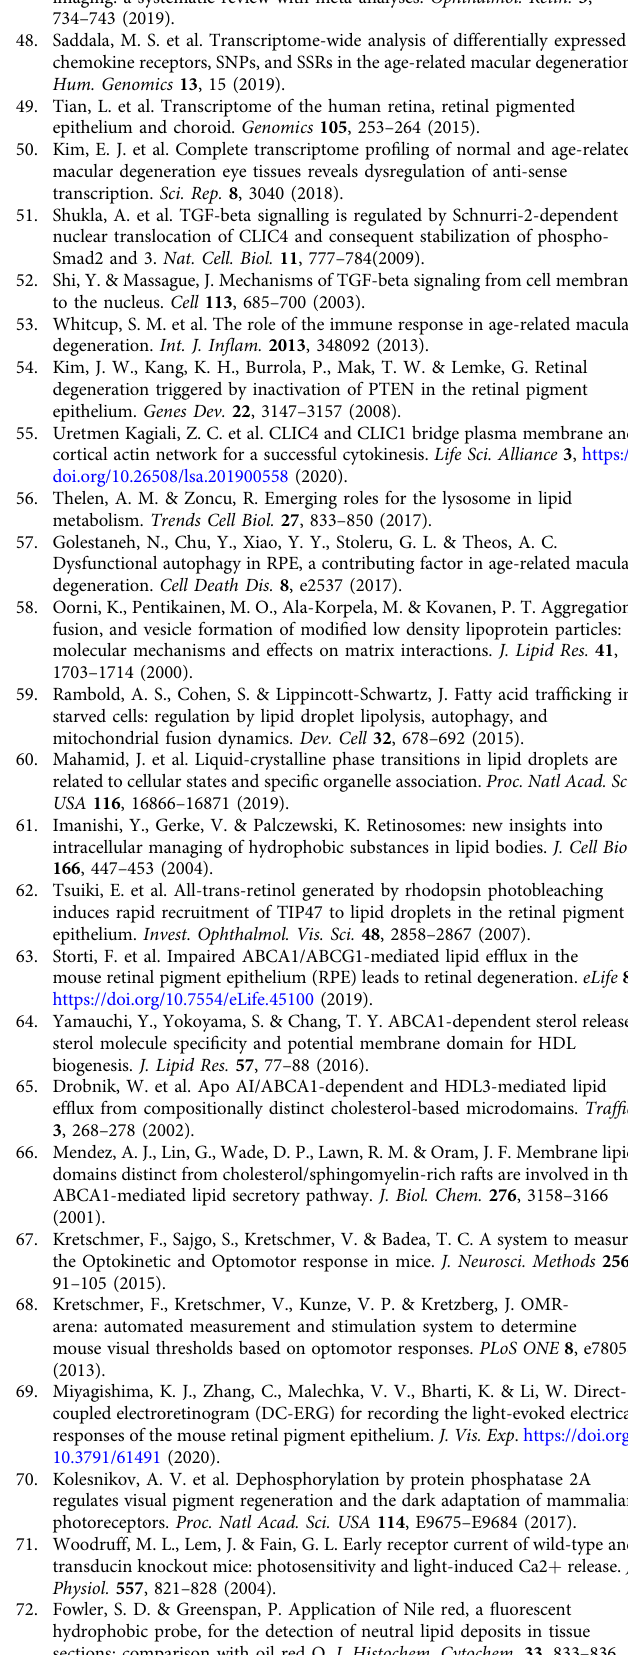
sections: comparison with oil red O. J. Histochem. Cytochem. 33 , 833 – 836